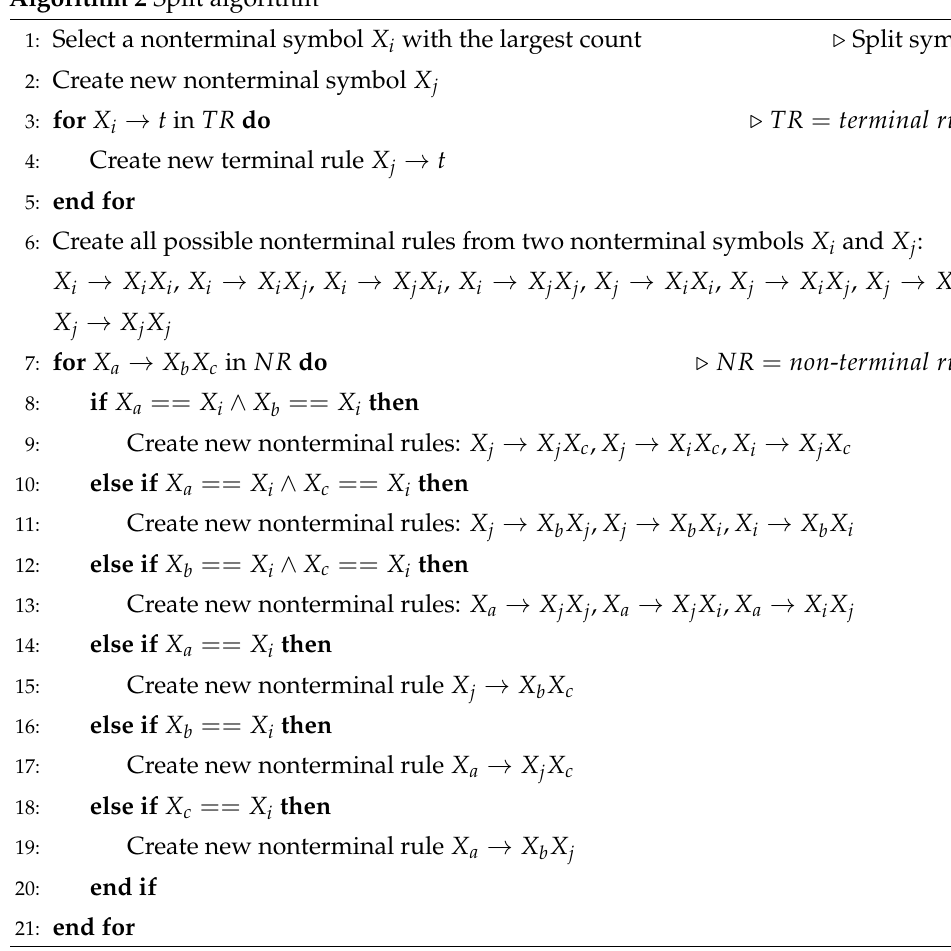
Algorithm 2 Split